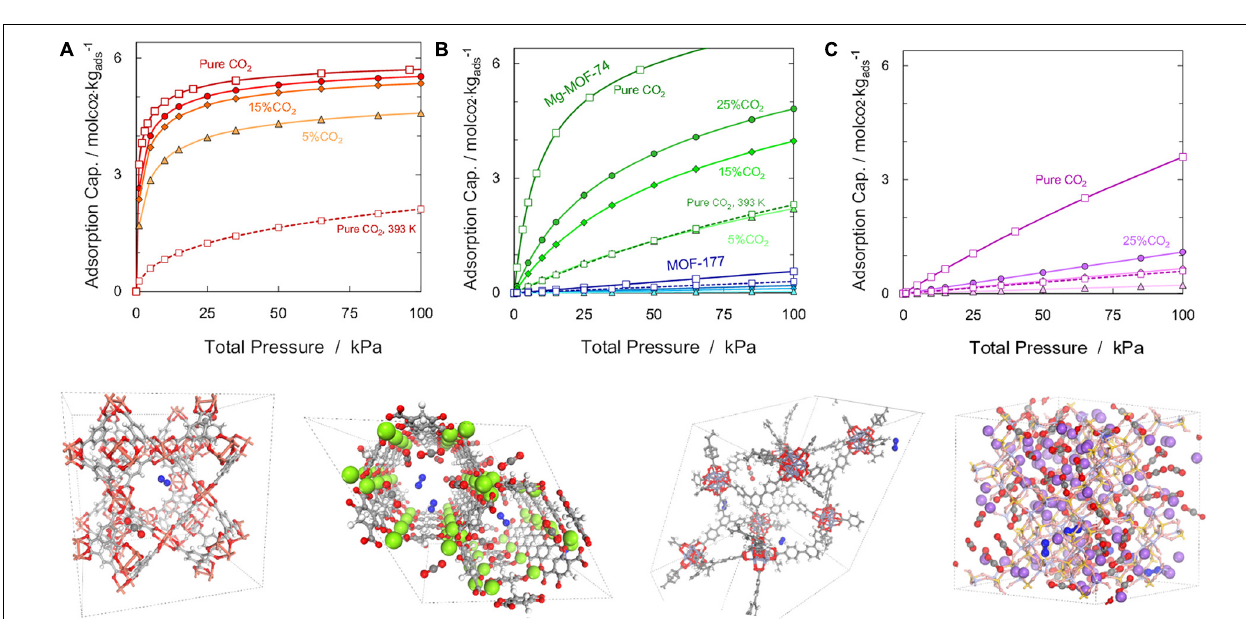
FIGURE 5 | Comparison of simulated adsorption isotherms for pure CO 2 on (A) representative metal–organic frameworks (MOFs) and (B) zeolites and other selected adsorbent materials. Dashed lines for functionalized materials. T ads = 313 K (MCM-41 at 323 K).